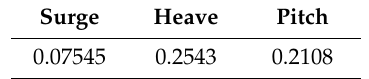
Table 3. Natural frequencies (rad / s) of the semisubmersible.